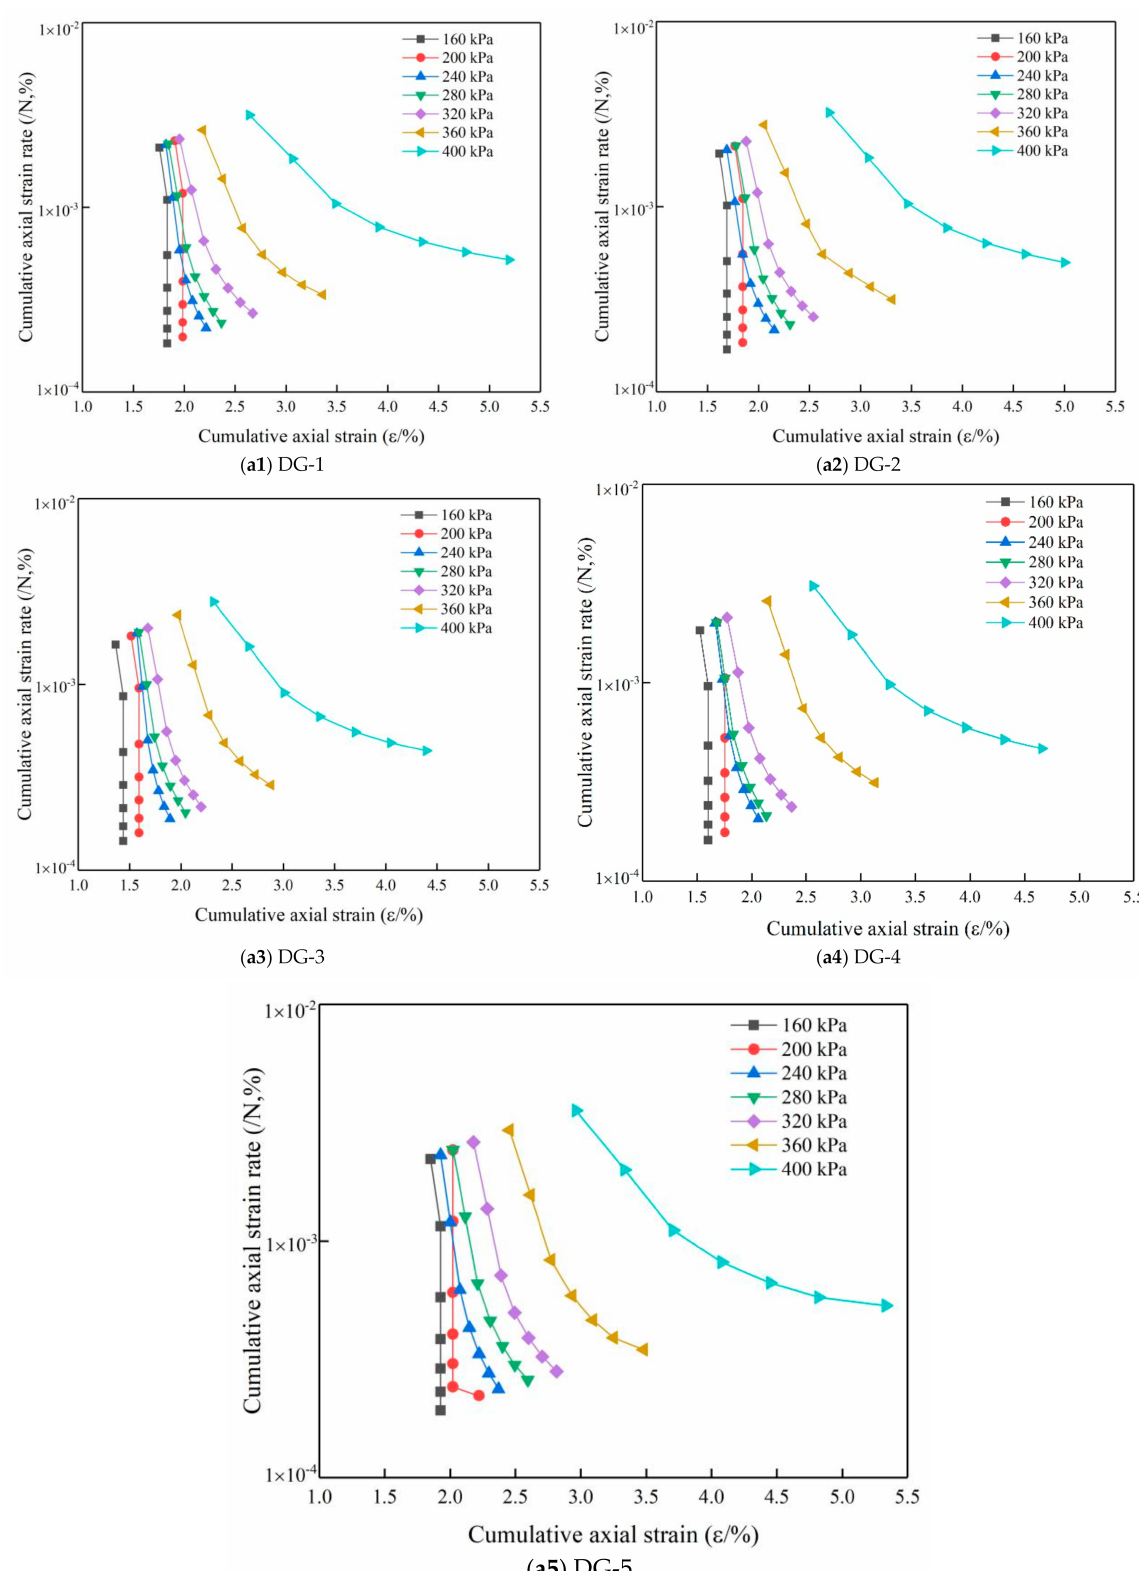
Figure 11. Axial strain change rate. ( a1 ) DG-1; ( a2 ) DG-2; ( a3 ) DG-3; ( a4 ) DG-4; ( a5 ) DG-5. As shown in Figure 10a, the test results indicate that the deformation relationships for the large-size graded crushed stone specimens under cyclic rotating axial compression